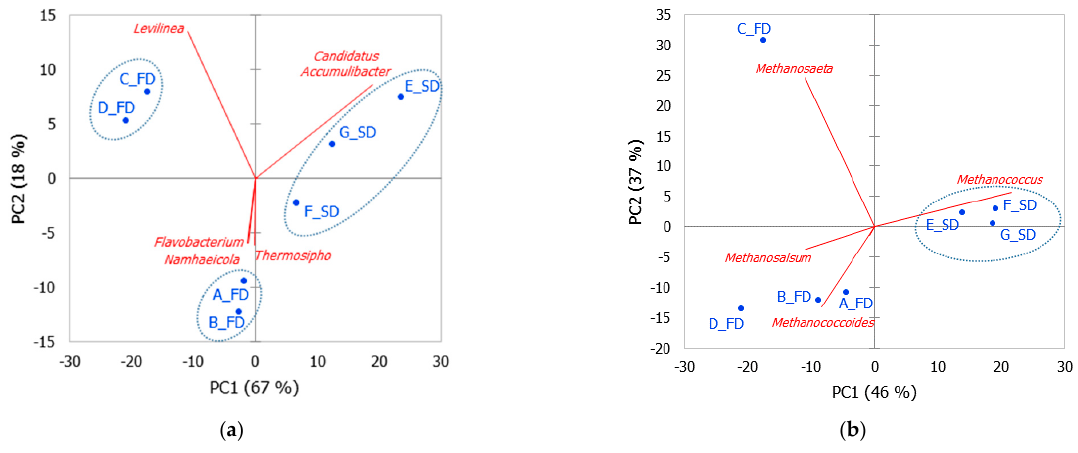
Figure 4. Principal component analysis of bacteria ( a ) and archaea ( b ) in seven full-scale anaerobic digestion plants treating food waste and sewage sludge (plots indicate only the most influential loadings).